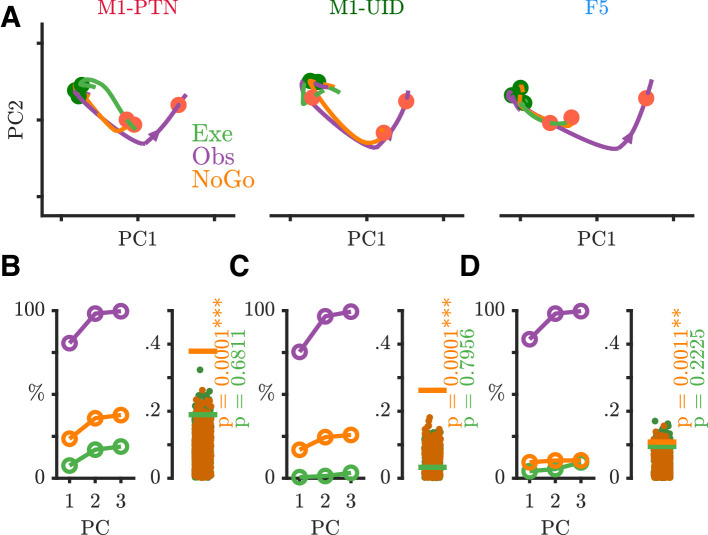
WHG observation and withholding.Evolution of neural trajectories around Go/NoGo cue in WHG observation subspace. All plotting conventions as in Figure 9.